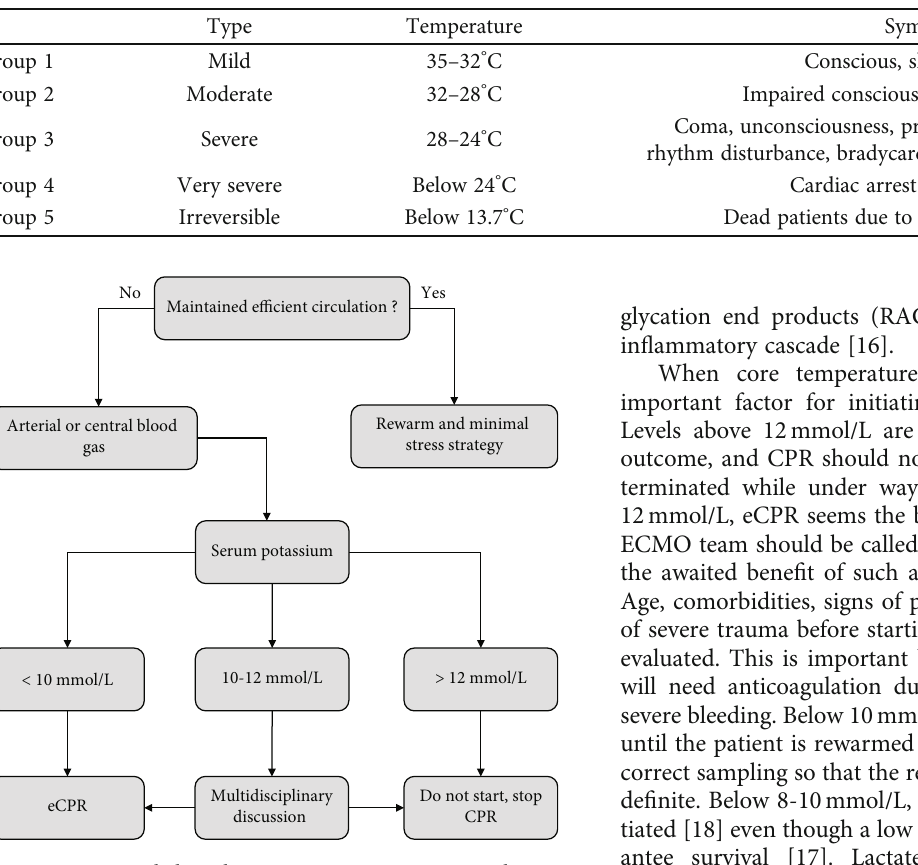
Figure 2: Decisional algorithm to start CPR in patients with severe hypothermia. Multidisciplinary discussion should include patient ’ s age, comorbidities, time of no fl ow and/or low fl ow, presence of severe trauma, or prearrest signs of